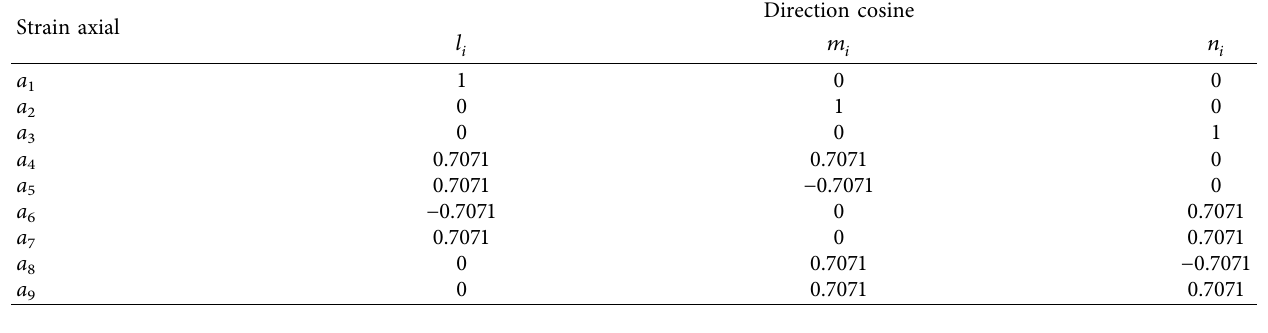
Table 1: Cosine values of each strain axis.